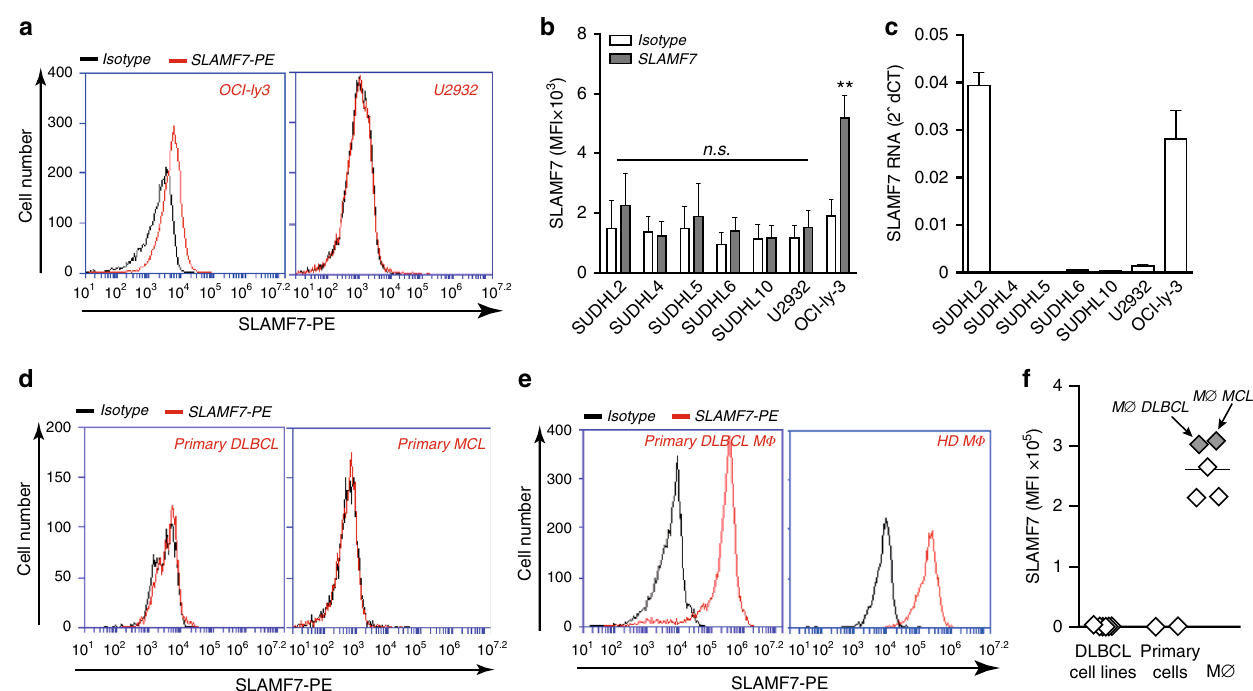
Fig. 1 SLAMF7 expresses on primary macrophages but not on DLBCL cells. a Representative graph of SLAMF7 expression in two DLBCL lines (SLAMF7 positive in OCI-ly3 cells, SLAMF7 negative in U2932 cells). b Surface expression levels of SLAMF7 in a panel of seven DBLCL cell lines ( n = 3). c mRNA expression levels of SLAMF7 in a panel of seven DLBCL cell lines ( n = 3). d Expression of SLAMF7 on primary patient-derived DLBCL cells. e Representative graph of SLAMF7 expression on macrophages from the DLBCL patient or healthy donors. f Quanti fi cation of SLAMF7 expression in DLBCL lines, primary patient-derived DLBCL cells, macrophages from healthy donors and macrophages from patients with B-cell malignancies. Error bars stand for standard deviation